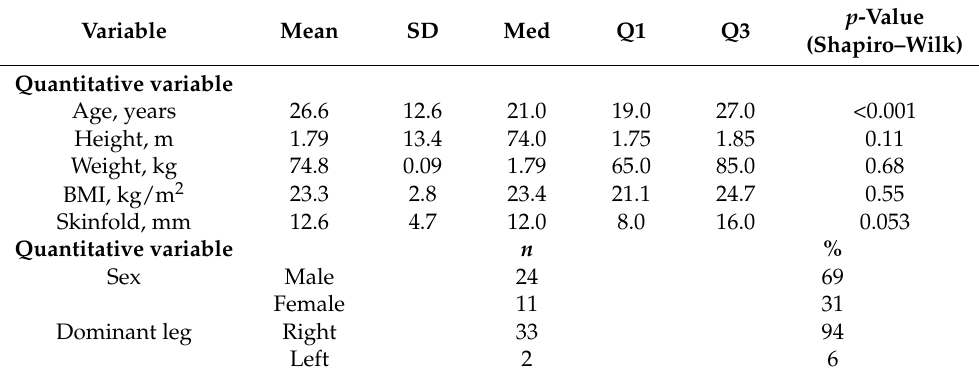
Table 1. Sample characteristics and analysis of normal